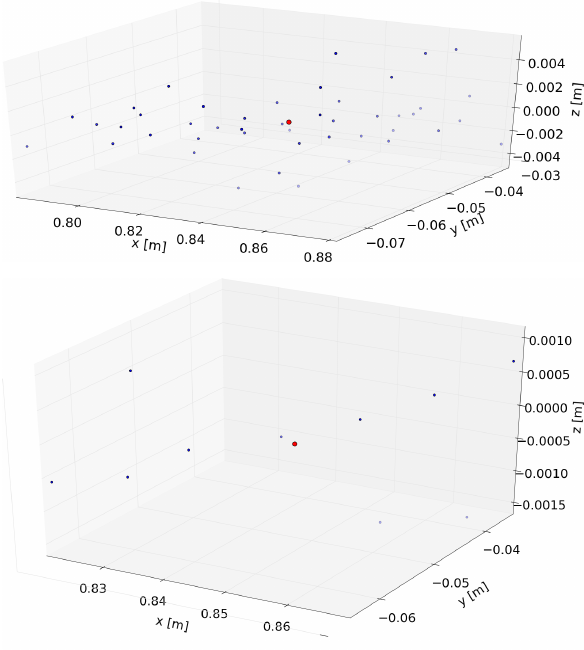
Figure 9. Signal double reflection phase centers for occurrence thresholds 50 (contributions from all aspects) and 100 (contributions from 7 aspects).